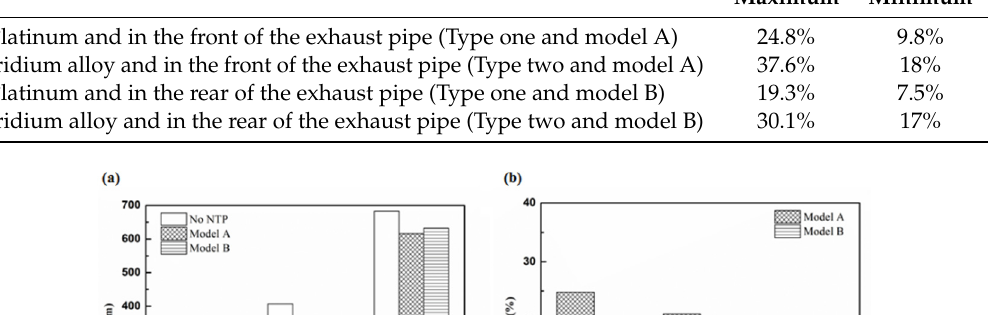
Table 9. The maximum and minimum values of NO x removal e ffi ciency at control voltage 5 V. Parameter